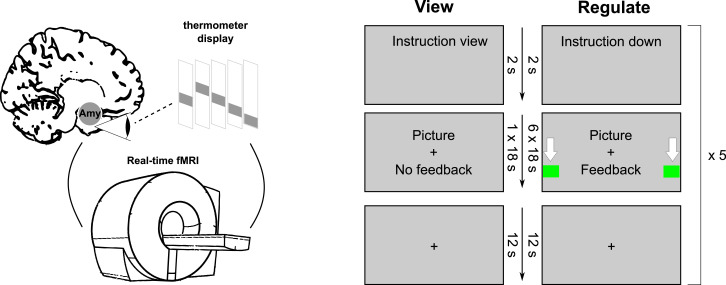
Experimental procedure of a neurofeedback training run. Participants viewed aversive pictures, with a feedback signal from their amygdala BOLD response, which is depicted as a thermometer. They were instructed to try to downregulate the temperature, representing their brain activation. They were also told to consider the temporal delay of the BOLD response, resulting in a time lag of the thermometer response (2–5 s). Furthermore, they should not close their eyes or shift their gaze from the screen and avoid focusing exclusively on the thermometer or borders of the picture. They should not hold their breath or move their heads. After participants entered the scanner, anatomical and fieldmap scans were acquired. Before the first neurofeedback run, a demonstration trial was presented without fMRI scanning. Subjects were instructed beforehand to look at the picture (without feedback), or to downregulate the thermometer signal. The neurofeedback consisted of ‘down’ and ‘view’ conditions, respectively. In the ‘view’ condition, a picture with negative emotional content was shown for 18 s, followed by a fixation cross on a grey background (‘rest,’ 12 s). In the ‘down’ condition, pictures were presented with feedback. Six pictures were presented in a ‘down’ block, each for 18 s (108 s total). The order of conditions was fixed, with alternating ‘view’ and ‘down’ blocks. In total, there were 5 ‘down’ blocks and five ‘view’ blocks. After the last block, participants were instructed to rate their perceived regulation success (‘Were you able to regulate the display?’) on a 10-level visual analogue scale (results can be found in the supplement).